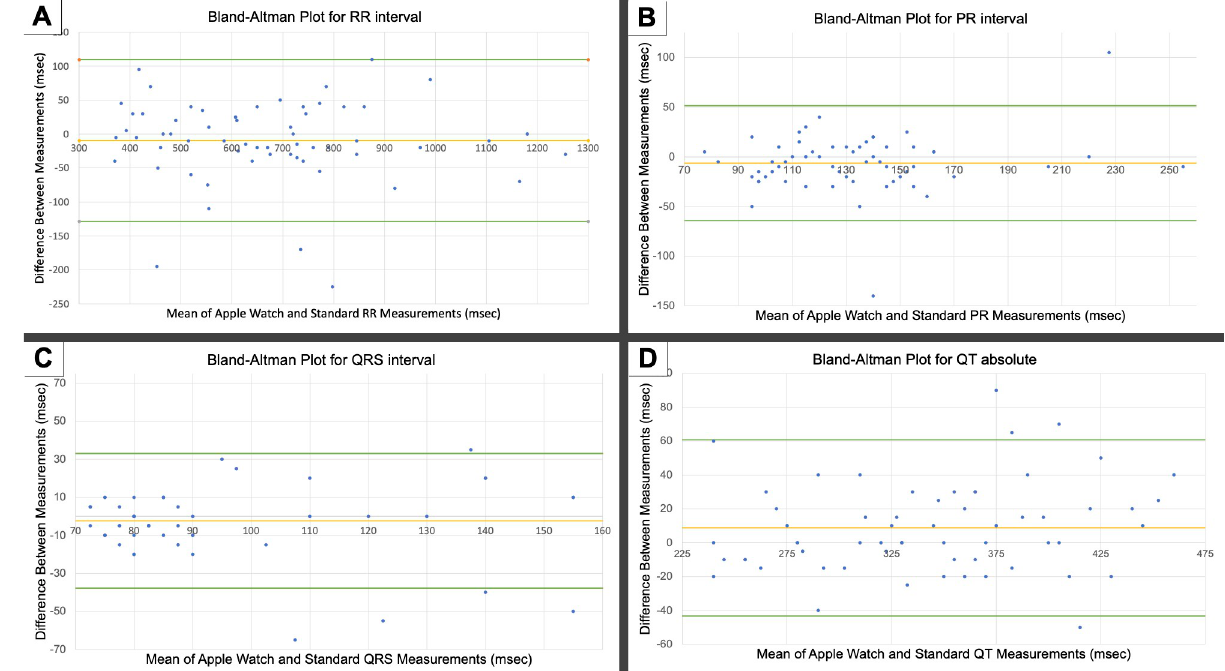
Fig 3. Bland Altman Analysis of AW6 ECG interval measurements compared to standard ECG: (A ) RR, (B) PR, (C) QRS, (D) QT absolute. Horizontal lines represent the mean difference of oxygen saturation between the Apple Watch 6 and standard pulse oximetry and the upper and lower limits of agreement (LOA). Upper and lower LOA represent +1.96 and -1.96 standard deviations respectively. Points may represent multiple patients.